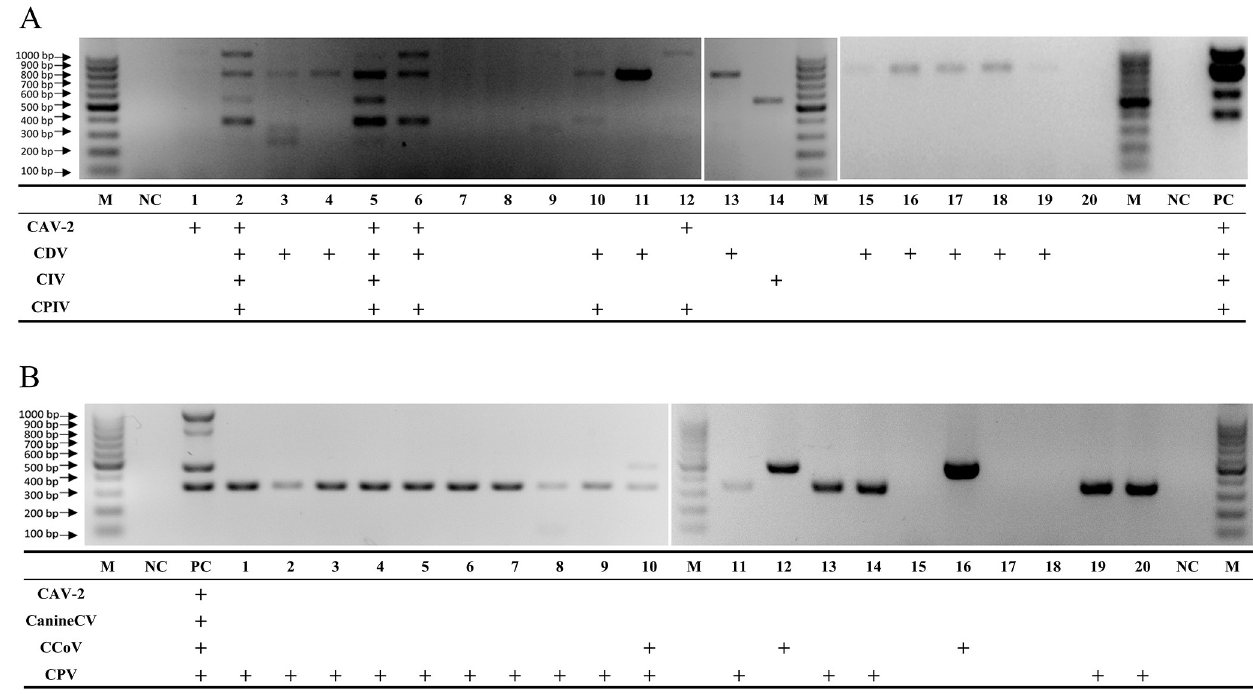
Fig 6. Evaluation of clinical samples. 20 NS and 20 AS clinical samples were tested by established mPCRs respectively. (A) CRV: Lane M, 100 bp DNA ladder; Lanes PC, positive controls; Lanes NC, negative controls; Lanes 1~20, multiplex PCR tested on NS samples. (B) CEV: Lane M, 100 bp DNA ladder; Lanes PC, positive controls; Lanes NC, negative controls; Lanes 1~20, multiplex PCR tested on AS samples.